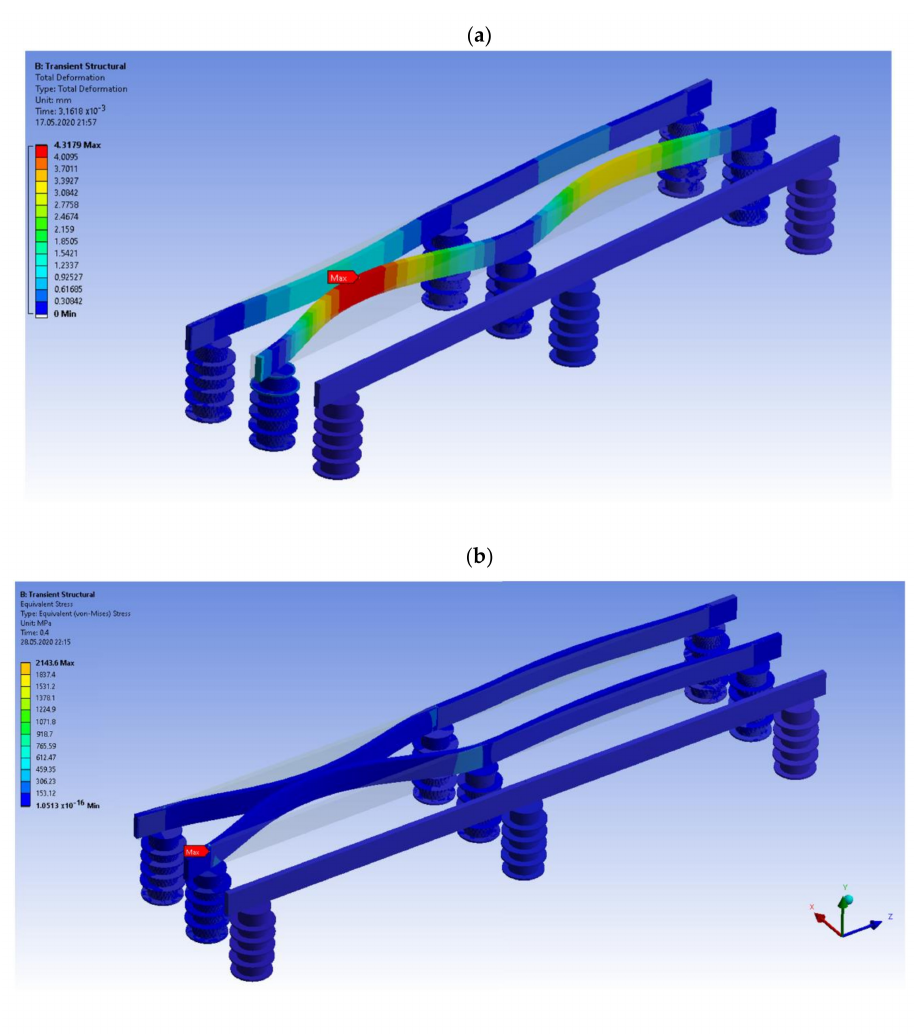
Figure 11. Simulation results for studied EIPB system (graphical): ( a ) Deformation in mm; ( b ) deformation in MPa (von